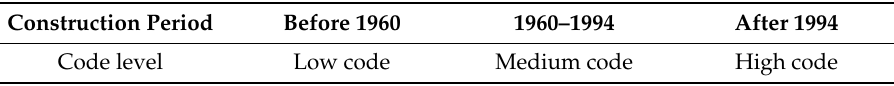
Table 3. Adopted code level for the existing buildings in